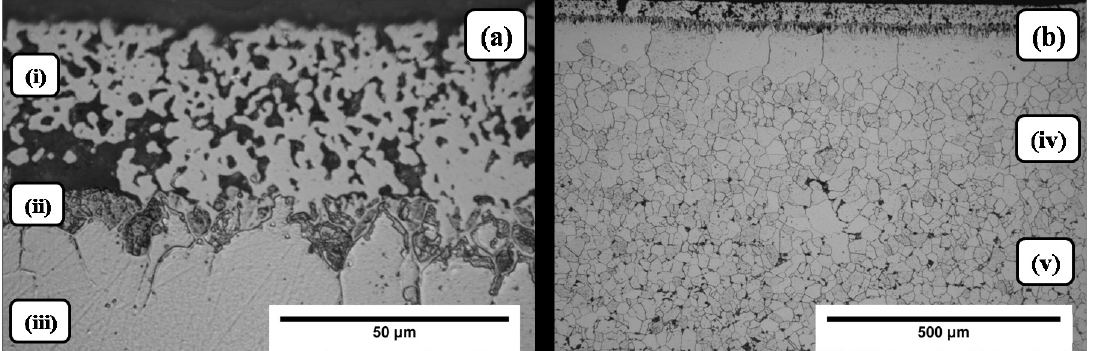
Figure 5: Microstructure distribution of the Ni-1%TiO2 composite. (a) First, second and third regions of the superficial microstructure. (i) Ni-TiO2 composite coating, (ii) Diffusion zone and; (iii) Large grains; (b) Full Ni-1%TiO2 composite microstructure. (iv) Ferrite grains and; (v) Ferrite-Pearlite